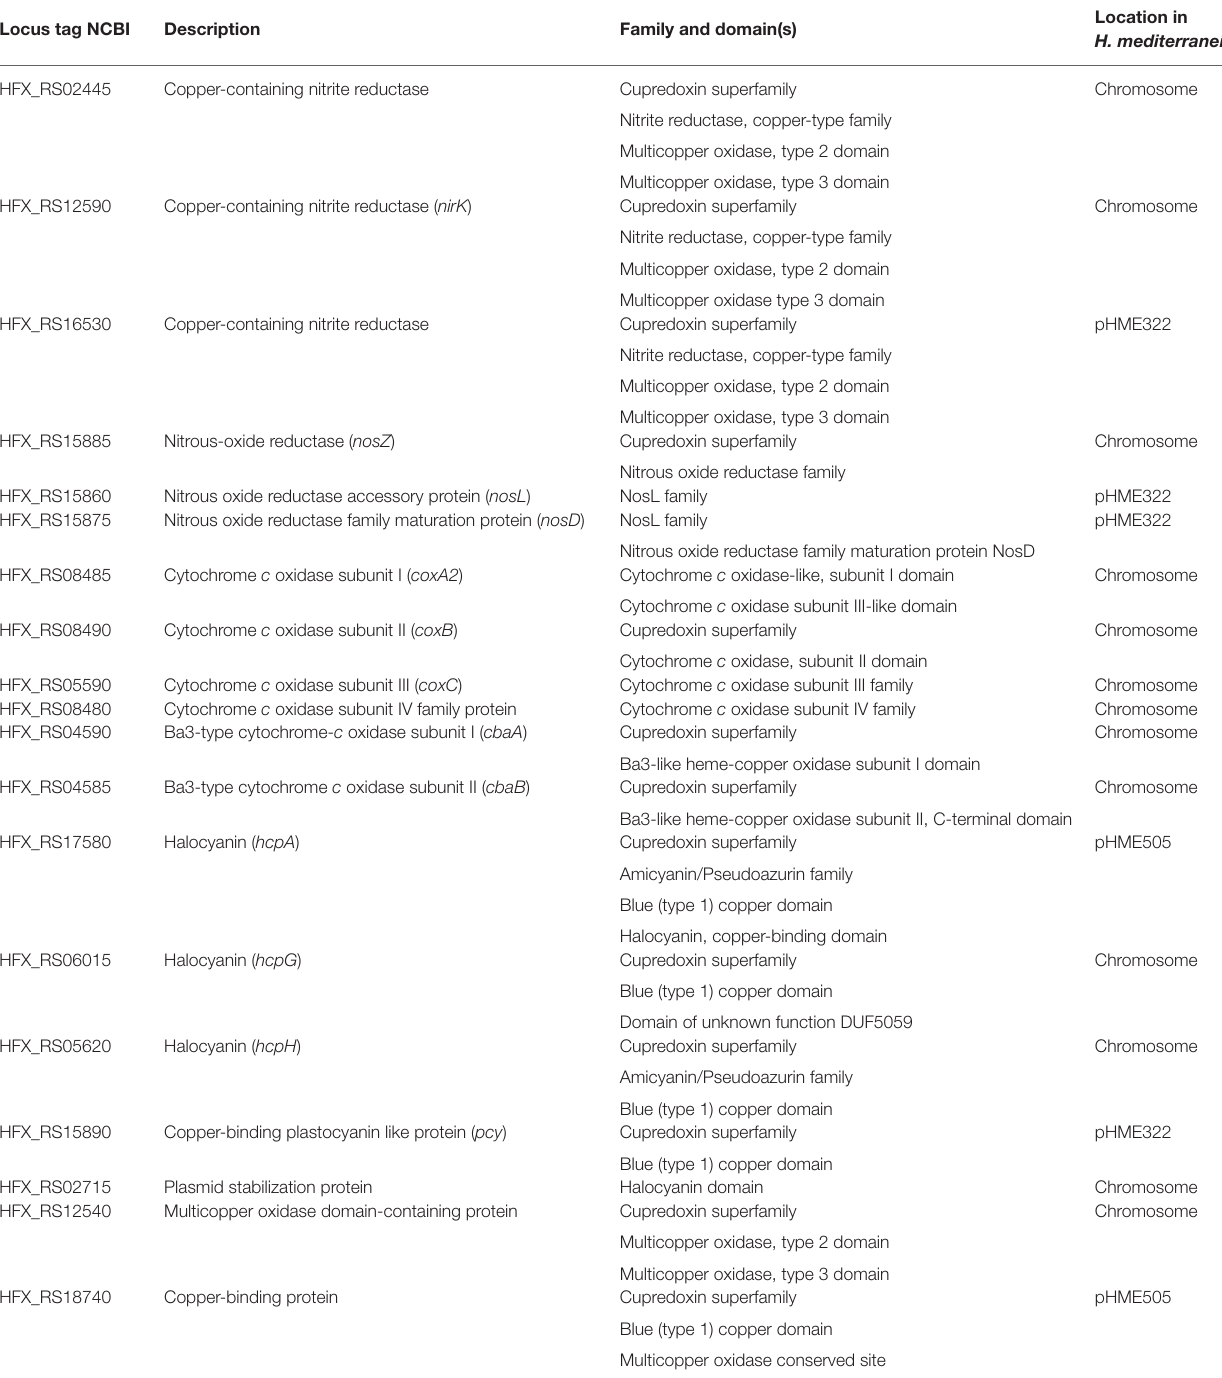
TABLE 3 | Genes coding for cupredoxin-containing proteins found in Haloferax mediterranei genome. Locus tag